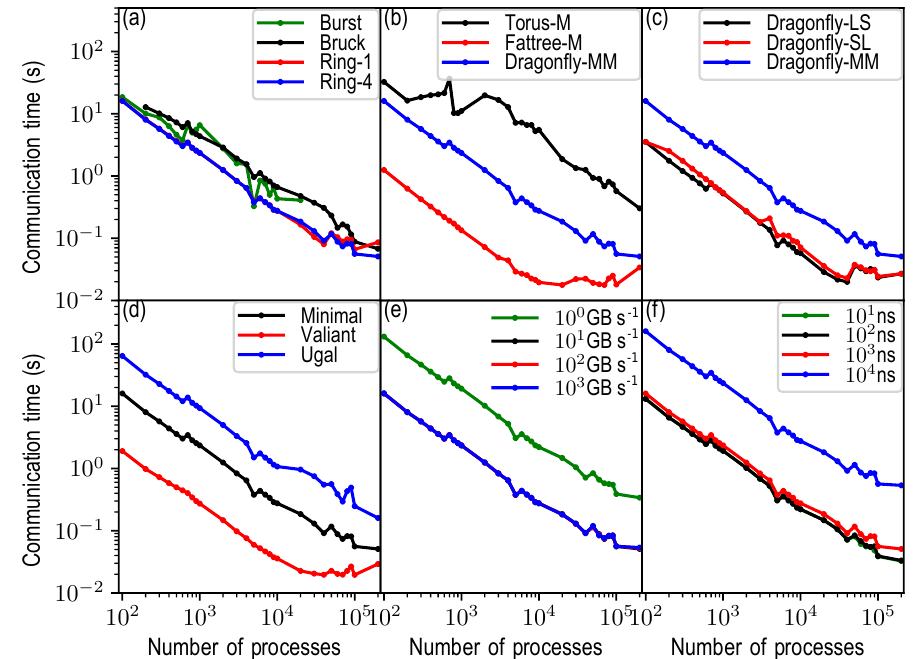
Figure 5. Communication times of transposition for (a) alltoallv algorithms, (b) topologies, (c) configurations of the dragonfly topology, (d) routing algorithms for the dragonfly topology, (e) bandwidth, and (f) latency. The circle markers indicate the numbers of processes of the corresponding simulations.